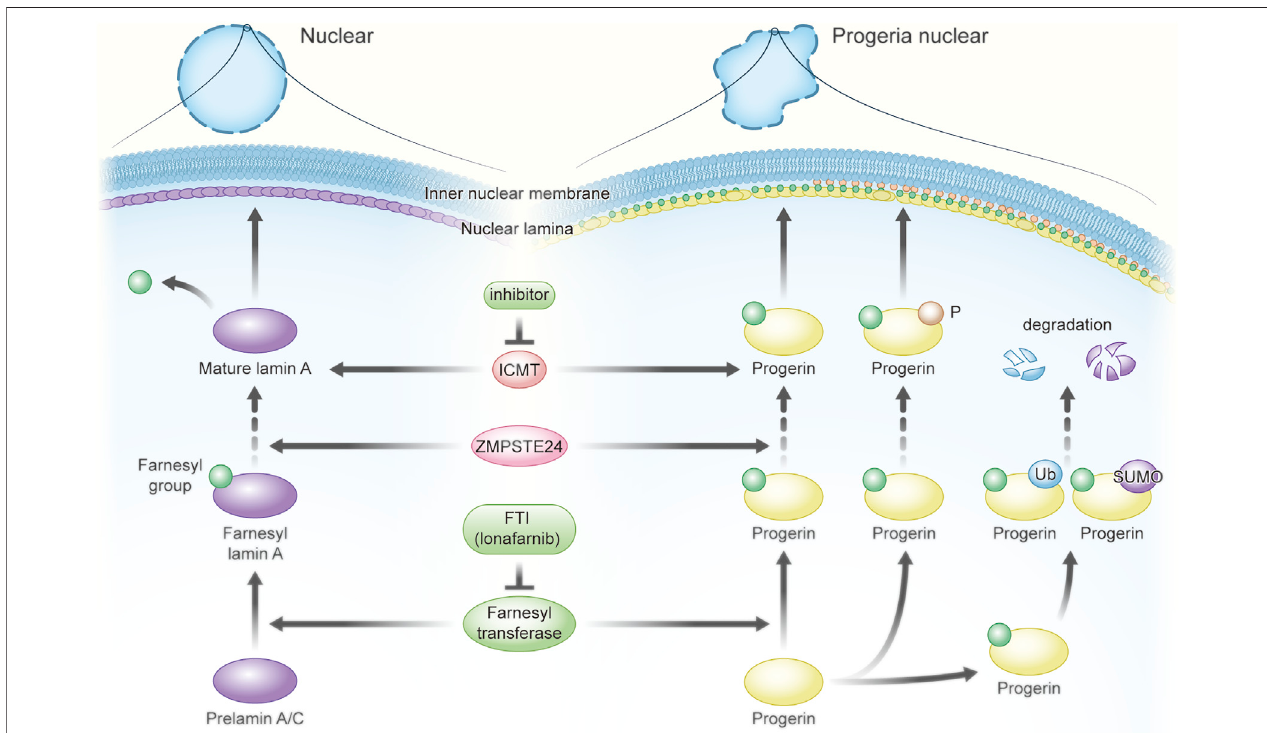
FIGURE 4 | Targeting PTMs of defective lamin A to improve Hutchinson – Gilford progeria syndrome (HGPS). Farnesyltransferase inhibitors (FTI) show promising therapeuticeffectsduetothereductionofprogerinaccumulation.TheorallyactiveFTIlonafarnib(Zokinvy ™ )hasbeenapprovedbytheFDAtoreducetheriskofmortality in HGPS and for the treatment of processing-de fi cient progeroid laminopathies in patients ≥ 12 months of age with a body surface area of ≥ 0.39 m 2 . Isoprenylcysteine carboxyl methyltransferase (ICMT), phosphorylation, SUMOylation, and ubiquitination of farnesylated prelamin A might also be potential targets for treatment.